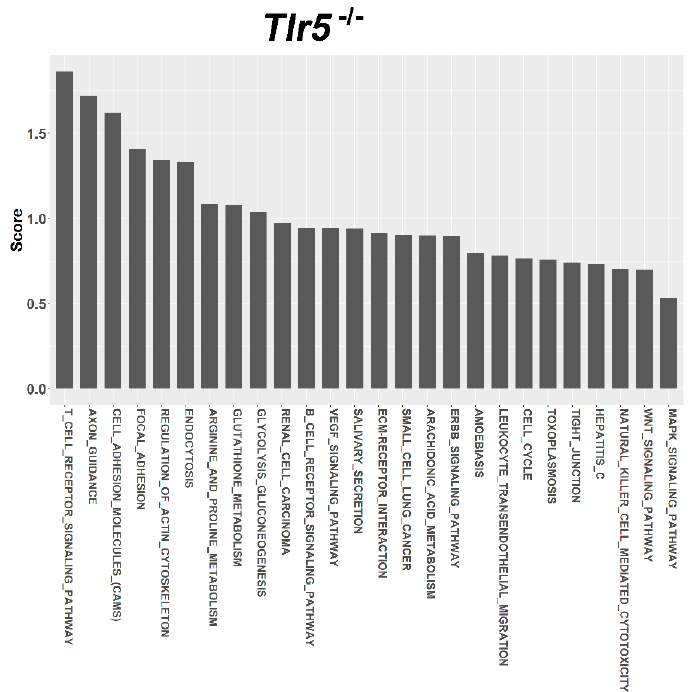
Figure 6 . Pathway ranking summery of the genes by the dysregulated miRNAs from miRSystem database during weight reduction in Tlr5 − / − mice. These pathways were annotated according to KEGG.